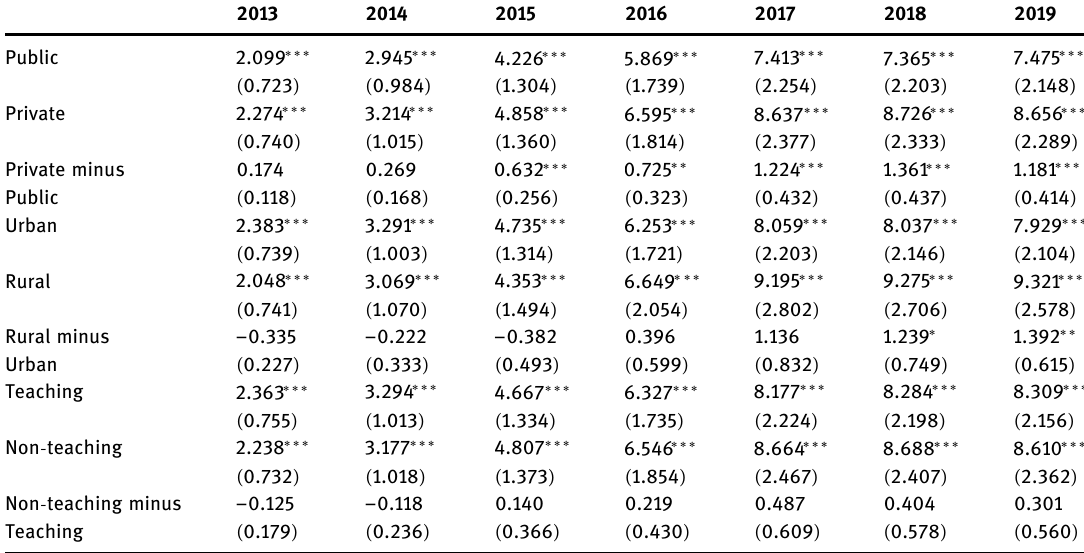
Table 7: E ff ect of pay - for - performance as ( ) ( ) μ α μ − 0 t by hospital ownership, teaching status, and urban